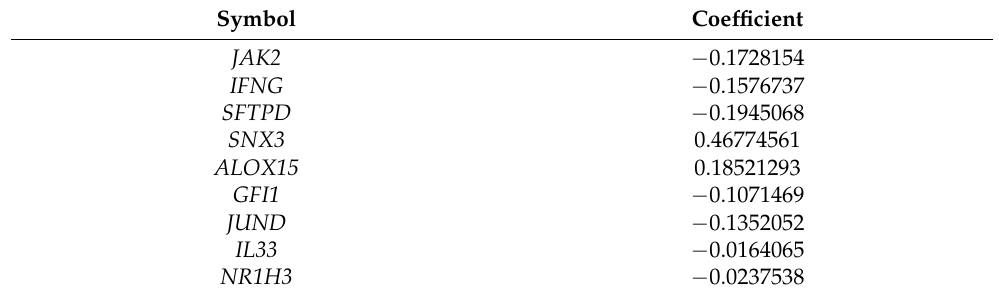
Figure 8. Lasso regression analysis. ( A ) The LASSO coefficient profile of OS-related genes, and an imaginary perpendicular line was drawn at the value chosen by 10-fold cross-validation. It reflects the association between coefficients and the L1 norm. ( B ) The tuning parameters (log λ ) of OS-related proteins were selected to cross-verify the error curve. According to the minimal and 1-se criterion, imaginary perpendicular lines were drawn at the optimal value ( C ) Lasso coefficients for 9 genes. Table 3. Lasso coefficient.